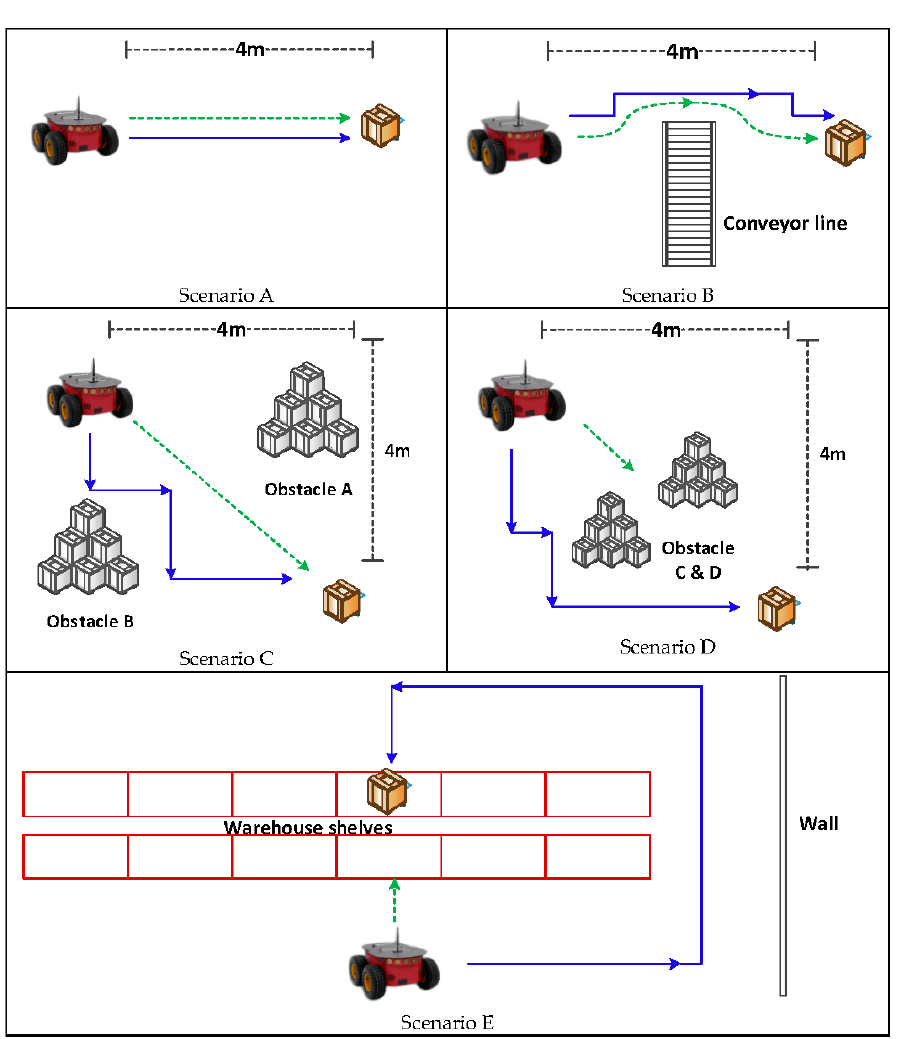
Figure 13. Diagrams showing the five test scenarios, with the expected paths of the preliminary system (green, dashed arrow) and the full system (blue, solid arrow). (green, dashed arrow) and the full system (blue, solid